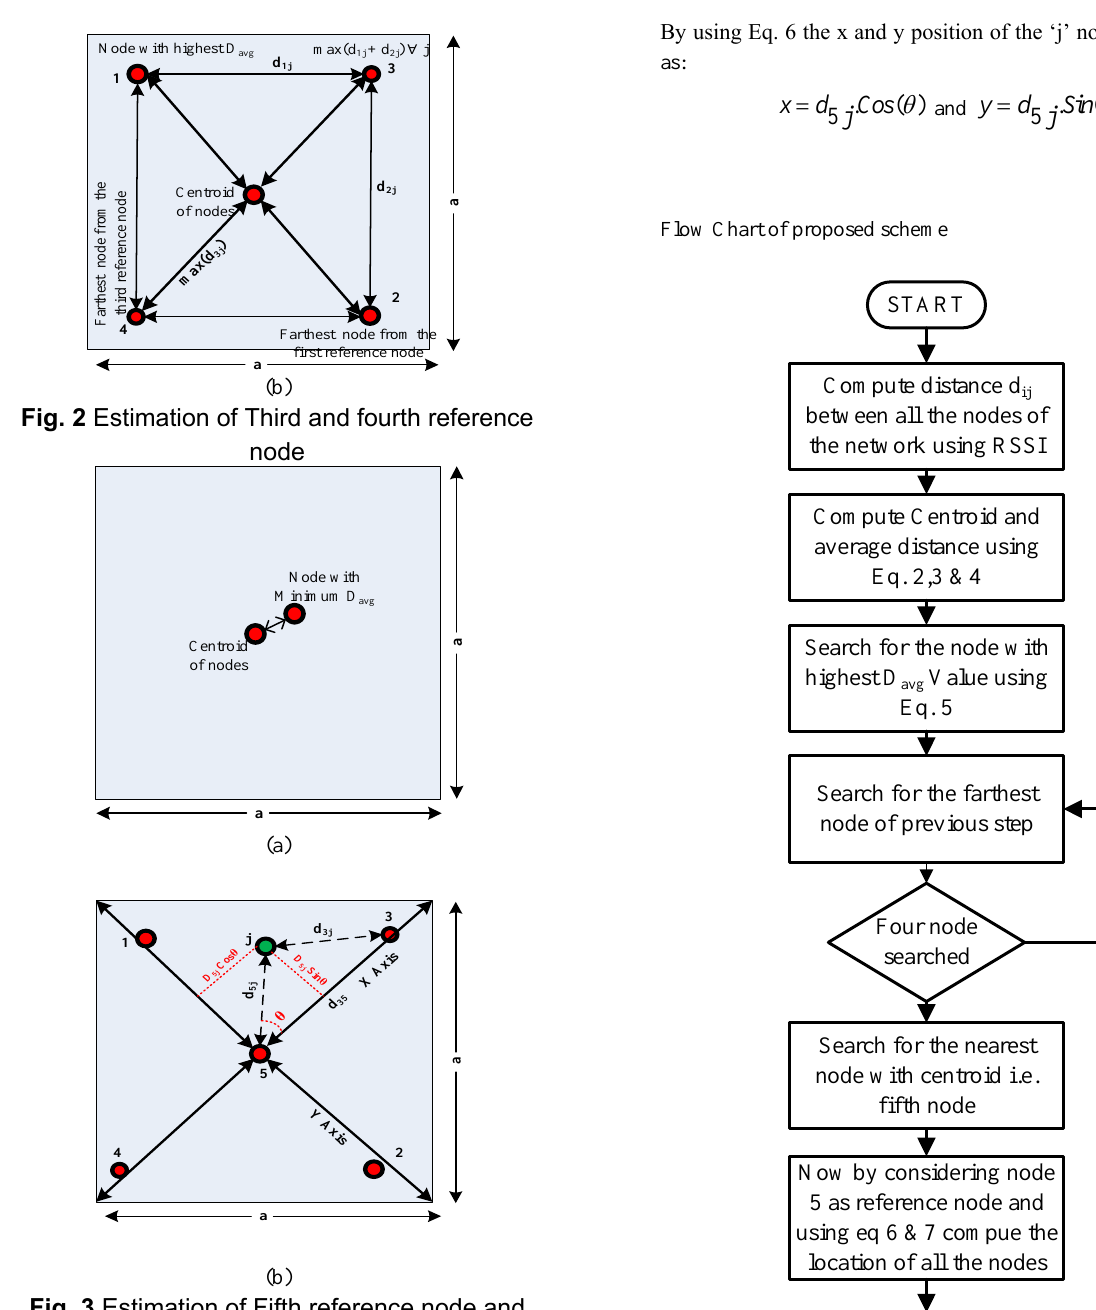
Fig. 3 Estimation of Fifth reference node and Localization of Node